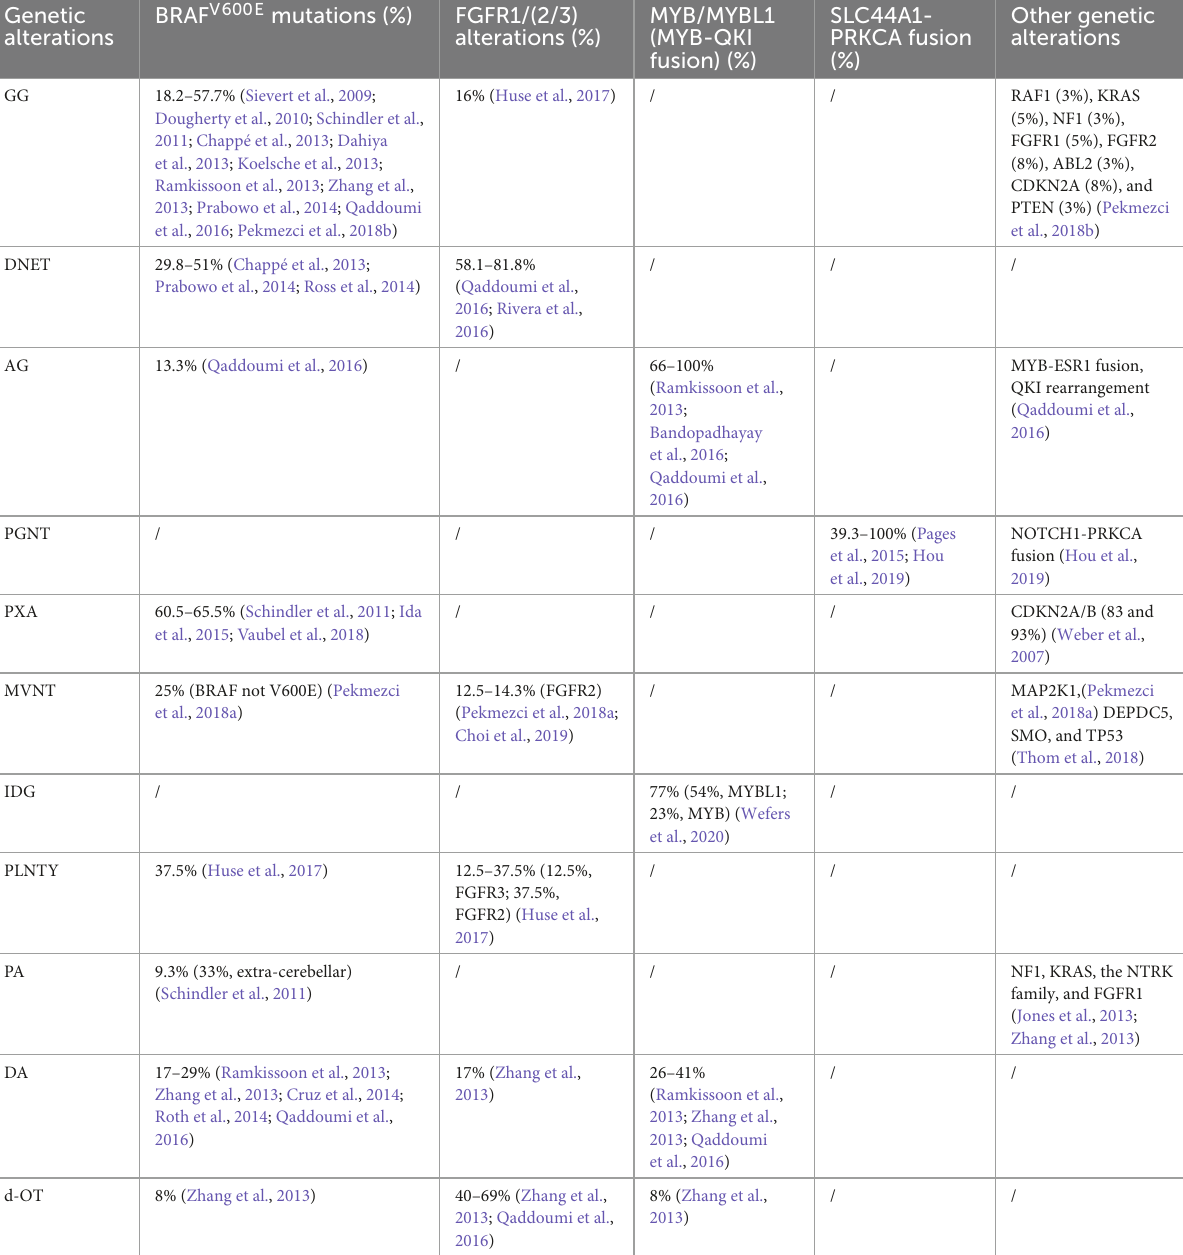
TABLE 2 The molecular genetic alterations in each tumor subtype of LEAT summarized from different case reports in the literature*. Genetic